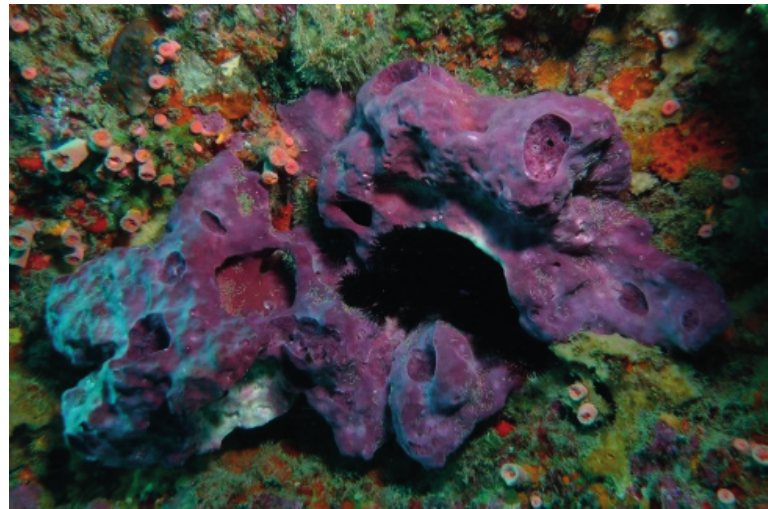
Figure 1. Sponge Petrosia sp.